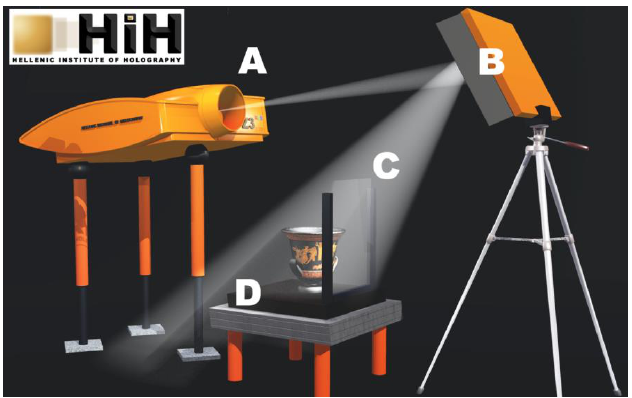
Figure 6. The mixed RGB laser beam from the ZZZyclops camera (A) is steered by mirror (B) to the holographic plate (C) and the object placed on the vibration isolation platform (D). The light reflected from the object interferes with the beam on the plate’s plane. The plate records the interference pattern during exposure.